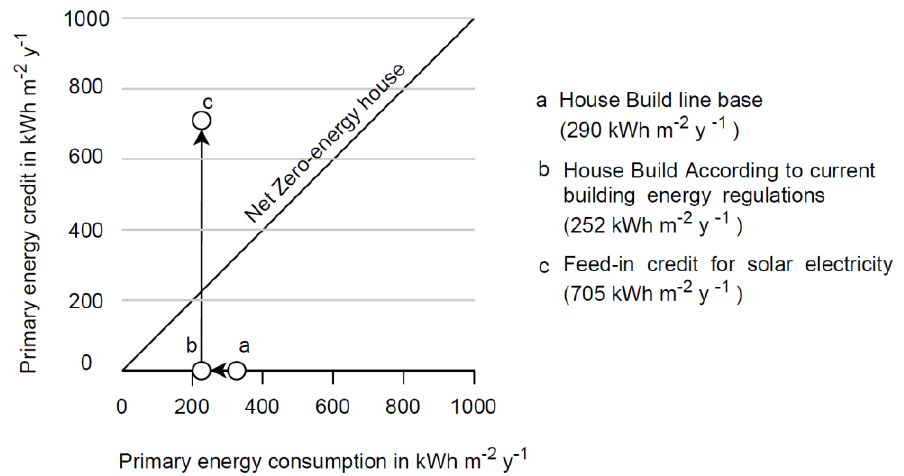
Figure 14 . ZEB definition for Panama, for a 60 m 2 dwelling: (a) House build Line Base [59] (Table 6, Figure 14. ZEB definition for Panama, for a 60 m 2 dwelling: ( a ) House build Line Base [59] (Table 6, A5), (b) Current building regulation [65], and (c) Feed-in proposed in this case from Table 6, A8. A5), ( b ) Current building regulation [65], and ( c ) Feed-in proposed in this case from Table 6, A8. Adopted from [70]. Adopted from